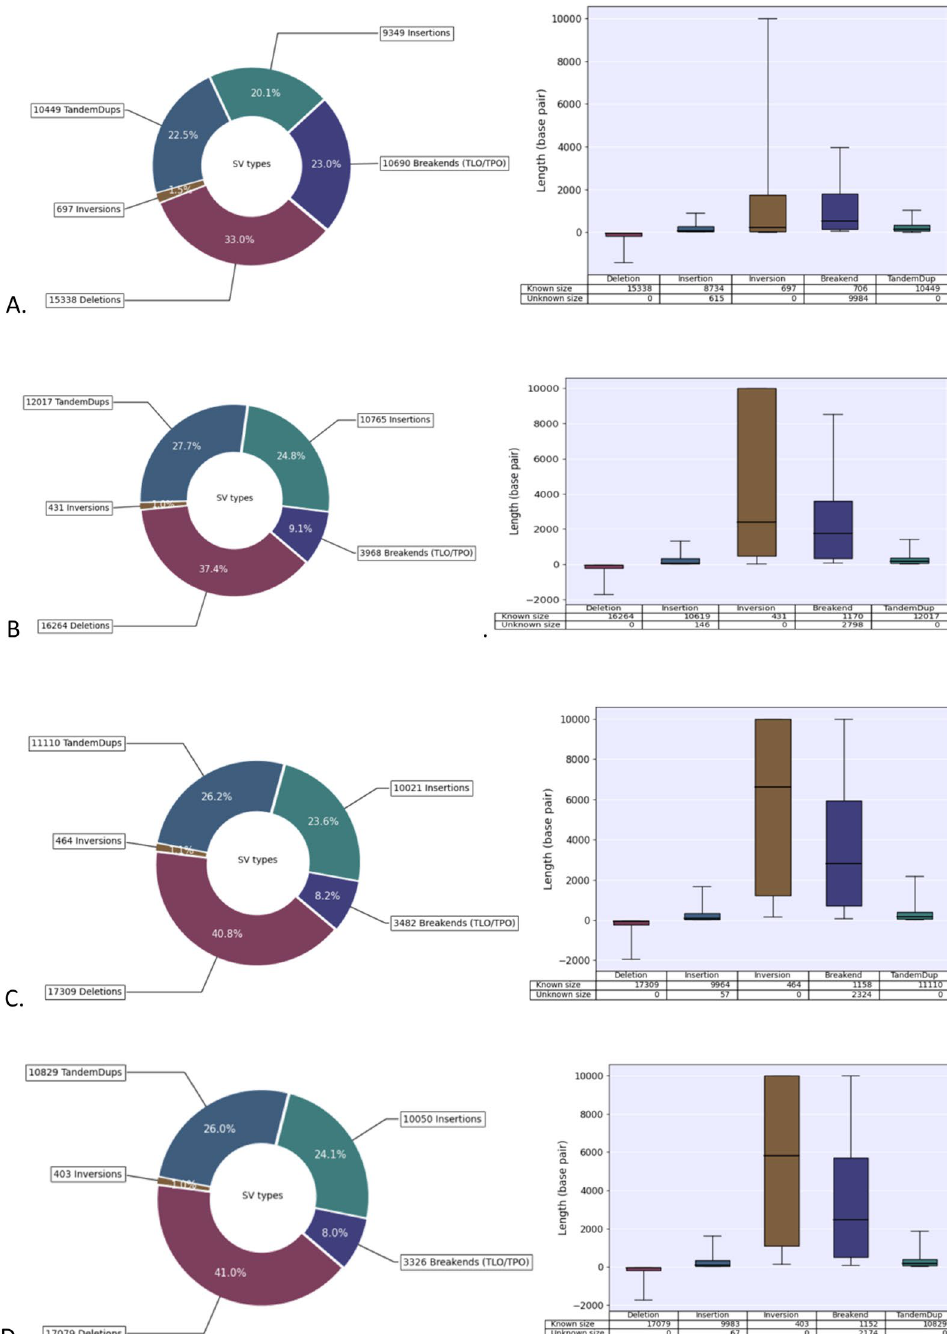
Figure 3. The pie chart is the SV percentage, and the bar chart is the SV base length. Results of whole gene SV testing: ( A ) 46, XX, t(X;3)(p22.3;q26.2) ( B ) 46, XY, t(13;16)(q34;q12.1). ( C ) 46, XX, t(1;3)(p22;p13) ( D ) 46, XY,